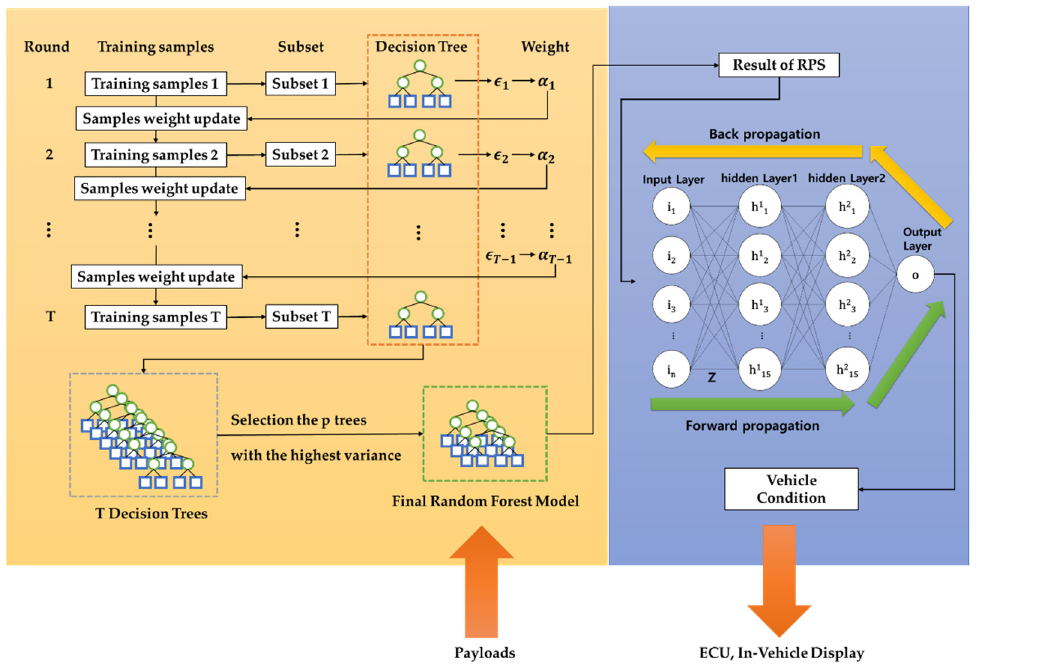
Figure 8. The structure of the in-vehicle diagnosis module (In-VDM).